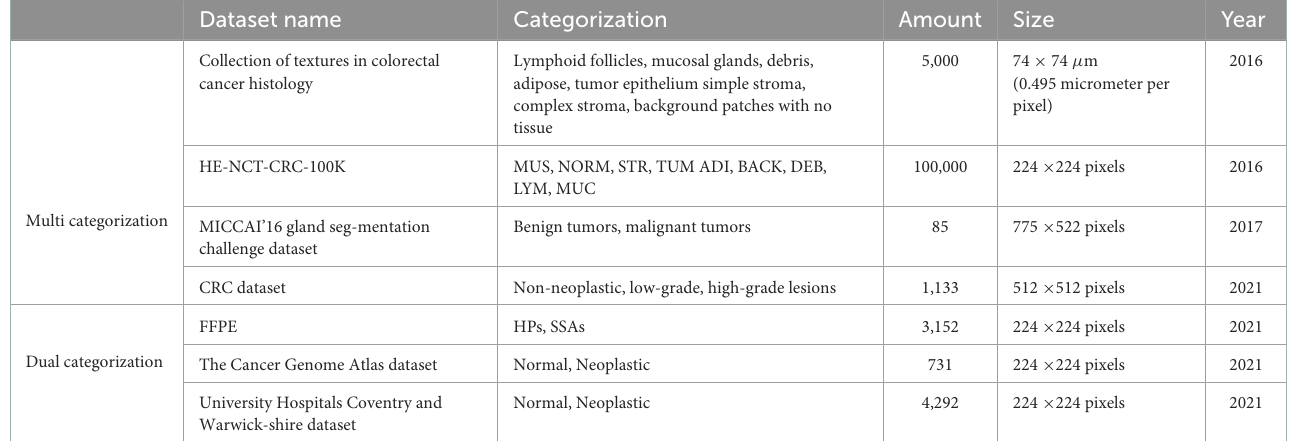
TABLE 1 A dataset for the pathological classification of colorectal